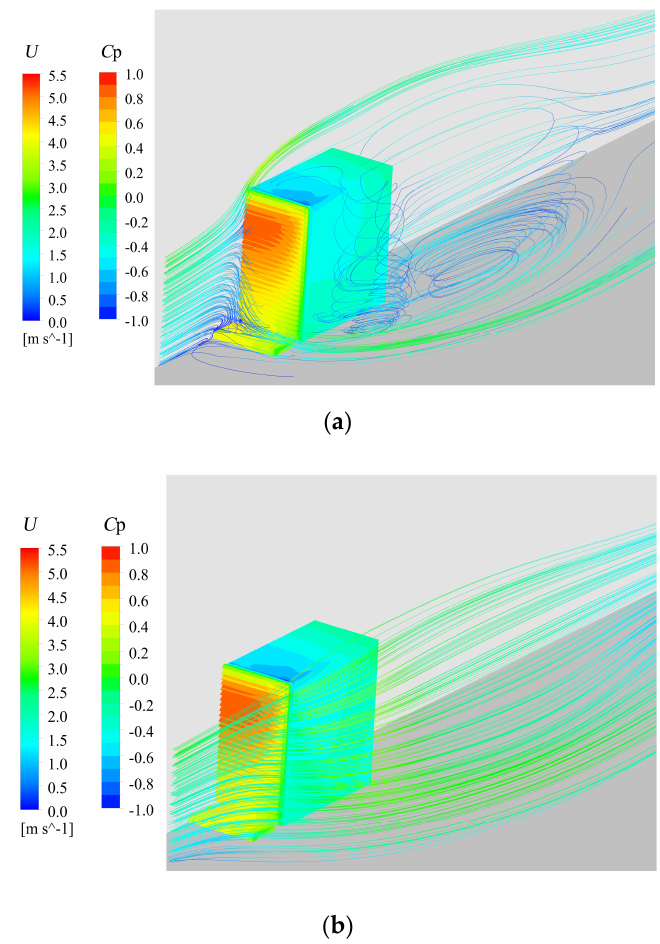
Figure 10. Airflow pattern and wind pressure distribution. ( a ) Airflow towards the central rows; ( b ) Airflow towards the side rows.